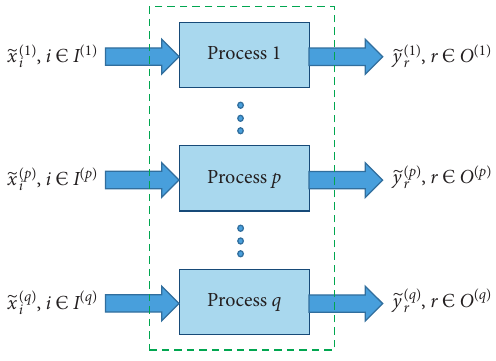
Figure 16: A parallel